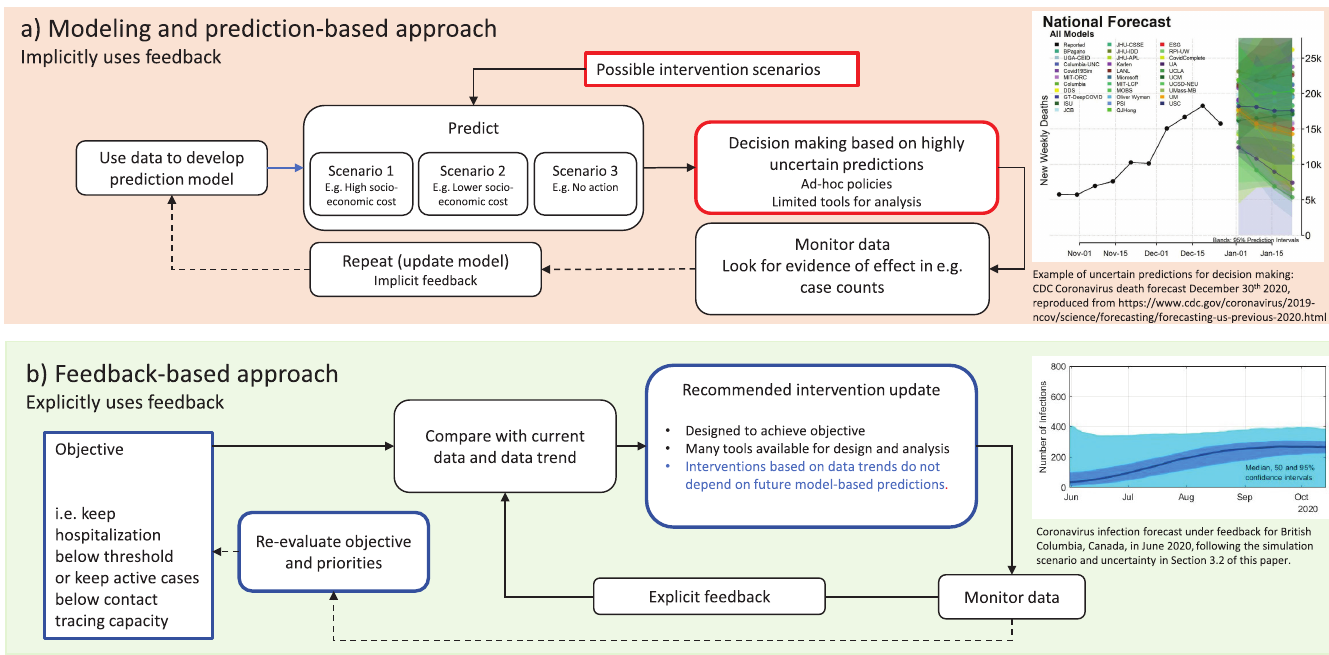
Fig 1. A: Schematic of the widely applied modeling and prediction-based approach to public health policy decision making, illustrating variability in predictions and the implicit feedback used for subsequent decisions. B: Schematic of a feedback-based approach, emphasizing the crucial role of feedback in modifying the spread of the